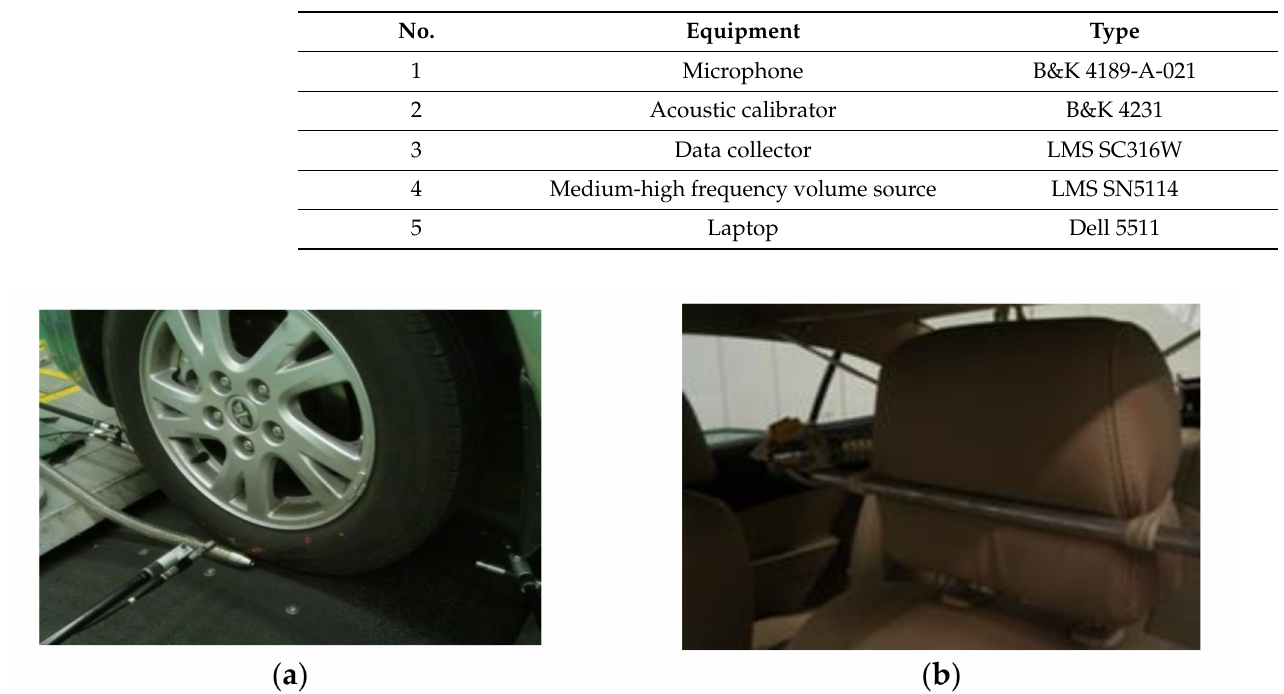
Table 1. Airborne noise transfer function measurement equipment.